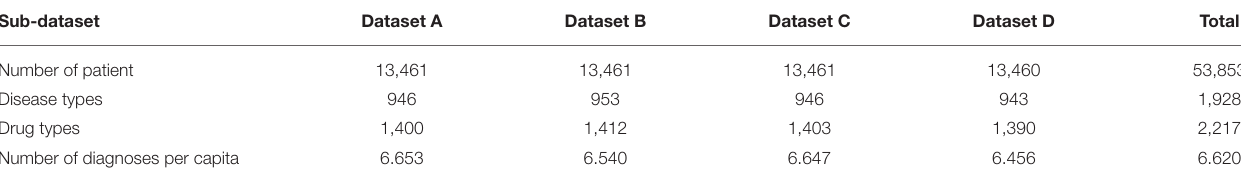
TABLE 2 | Description of